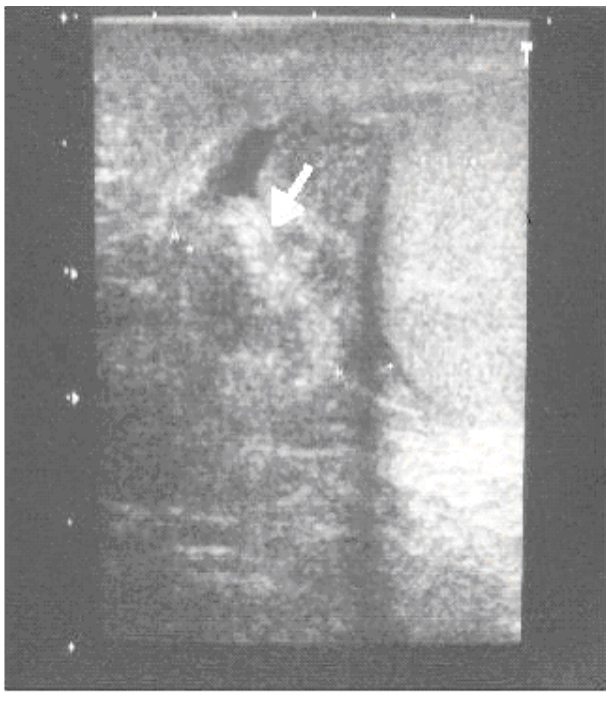
FIGURE 1. Ultrasound demonstrating epididymal swelling consistent with